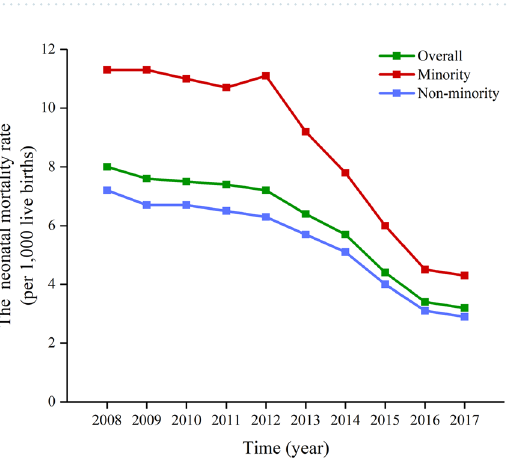
Figure 1. The time trend of U5MR in Sichuan Province.